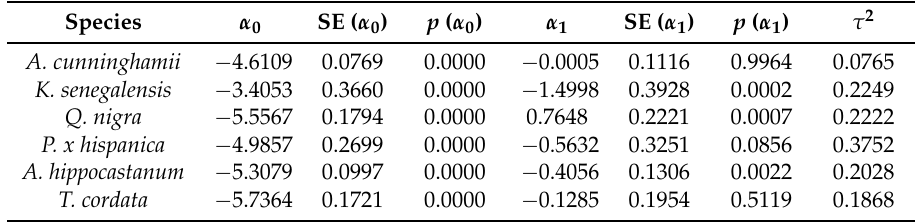
Table 6. Linear regression results for the basal area—basal area increment allometry and the influence of SCON Equation (7) for all six species (ordered according to